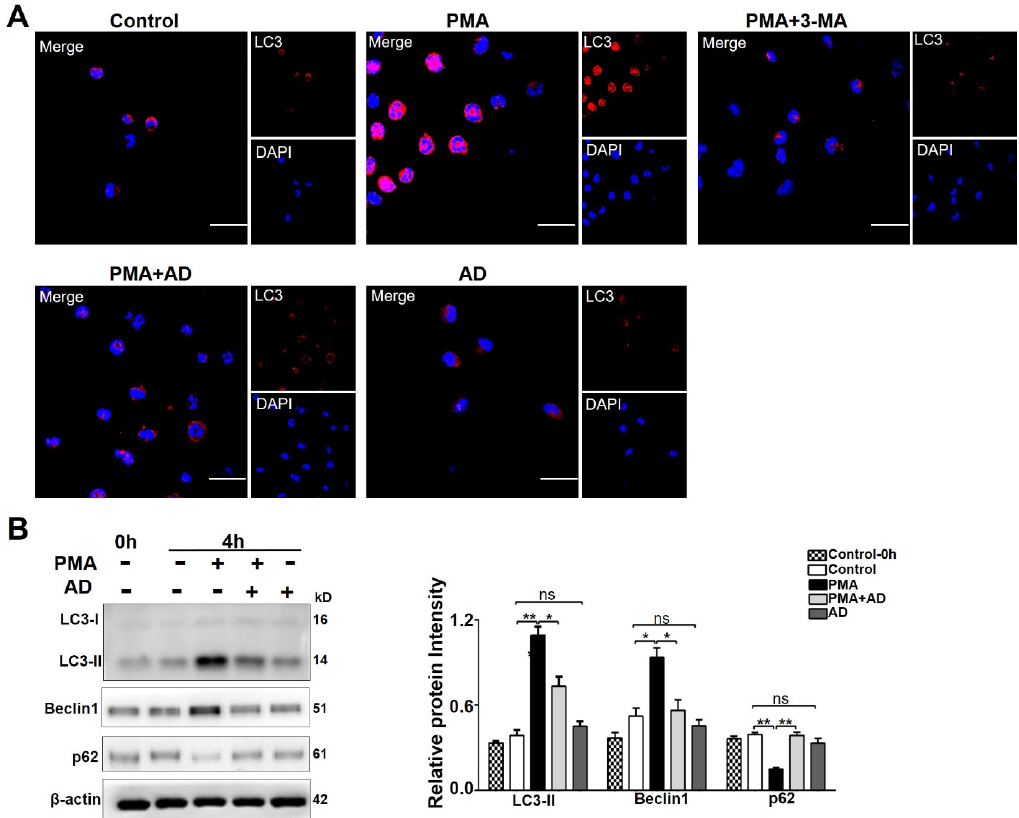
Figure 6. AD inhibited neutrophil autophagy. ( A ) Immunostaining of purified neutrophils with anti- microtubule-associated protein 1A/1B-light chain 3 (LC3) antibody. Representative images of more than three experiments are shown. Scale bar represents 10 μm. ( B ) Western blot analyses of LC3, Beclin1, and p62 in neutrophils treated with PMA (25 nM) or PMA (25 nM) + AD (25 μM) for 4 h. The relative gray values were quantified using Image J. The β-actin was an internal control. Data indicate mean ± SD of three independent experiments, * p < 0.05, ** p < 0.01. 3-MA: 3-methyladenine.